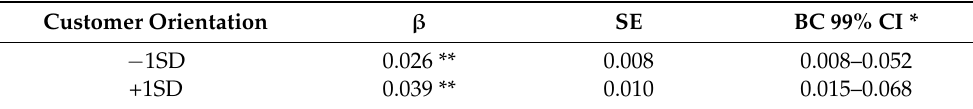
Table 12. Moderated mediating effect according to customer orientation.